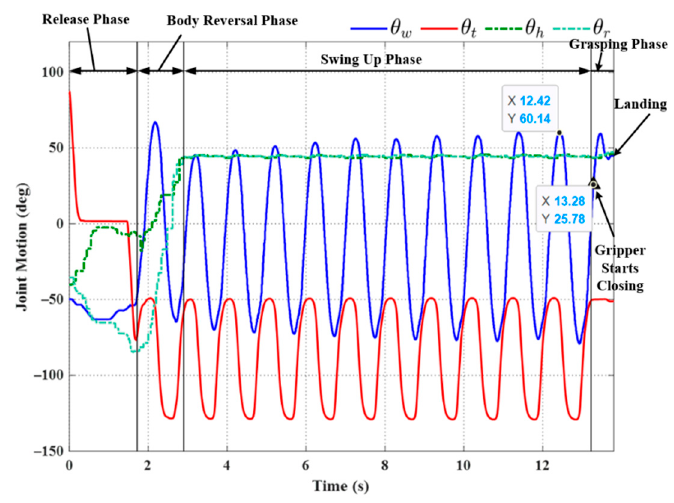
Figure 19. Experimental results: joint motion in Experiment (d).